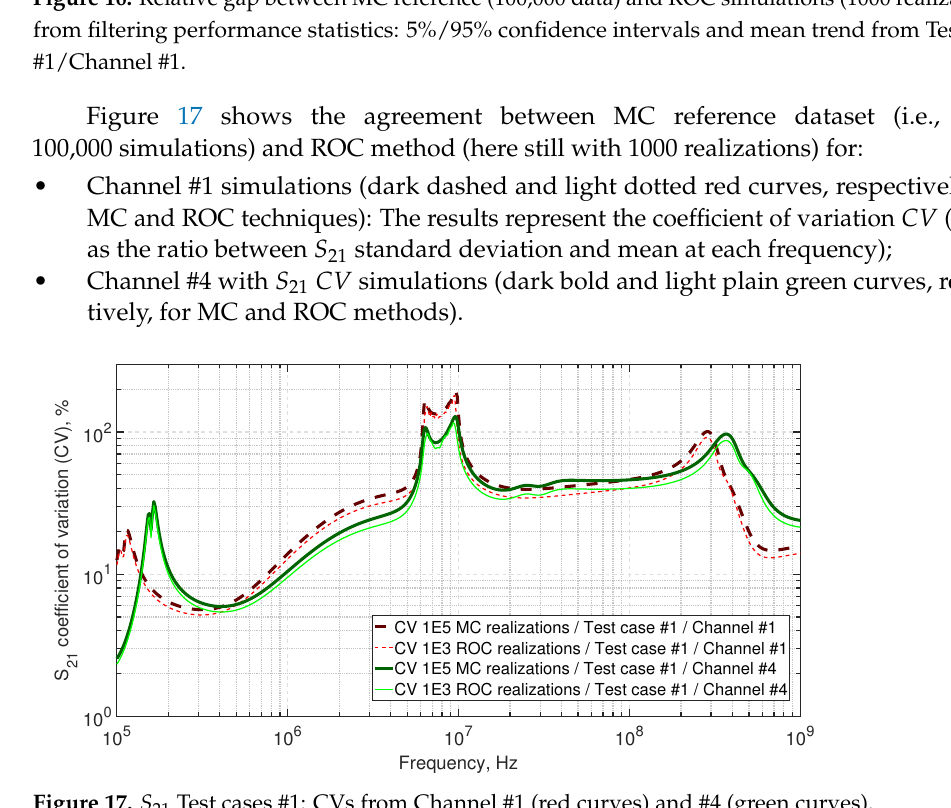
Figure 17. S 21 Test cases #1: CVs from Channel #1 (red curves) and #4 (green